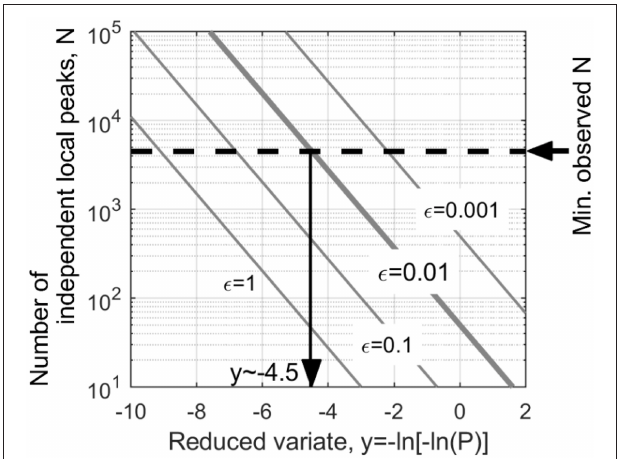
FIGURE 3 | XIMIS model error in y for lower tail.